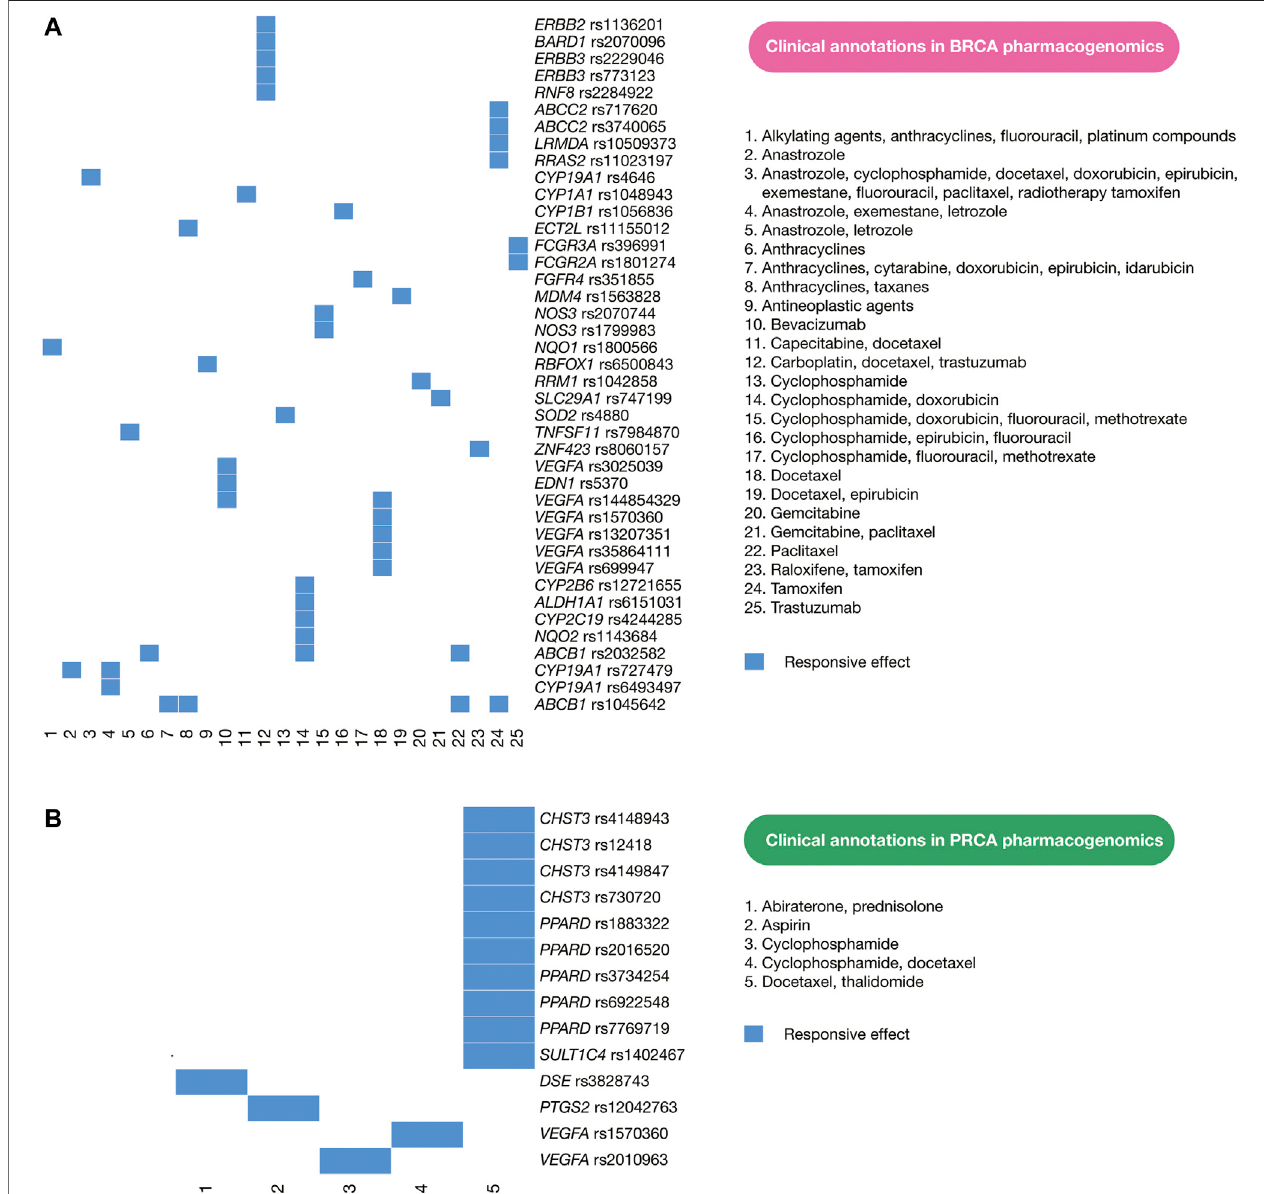
FIGURE 7| Current pharmacogenomics guidelines. (A) Clinical annotations of BRCA pharmacogenomics focused on responsive drug effects on human proteins. (B) Clinical annotations of PRCA pharmacogenomics focused on responsive drug effects on human proteins. These clinical annotations encompass cancer driver proteins and non-cancer driver